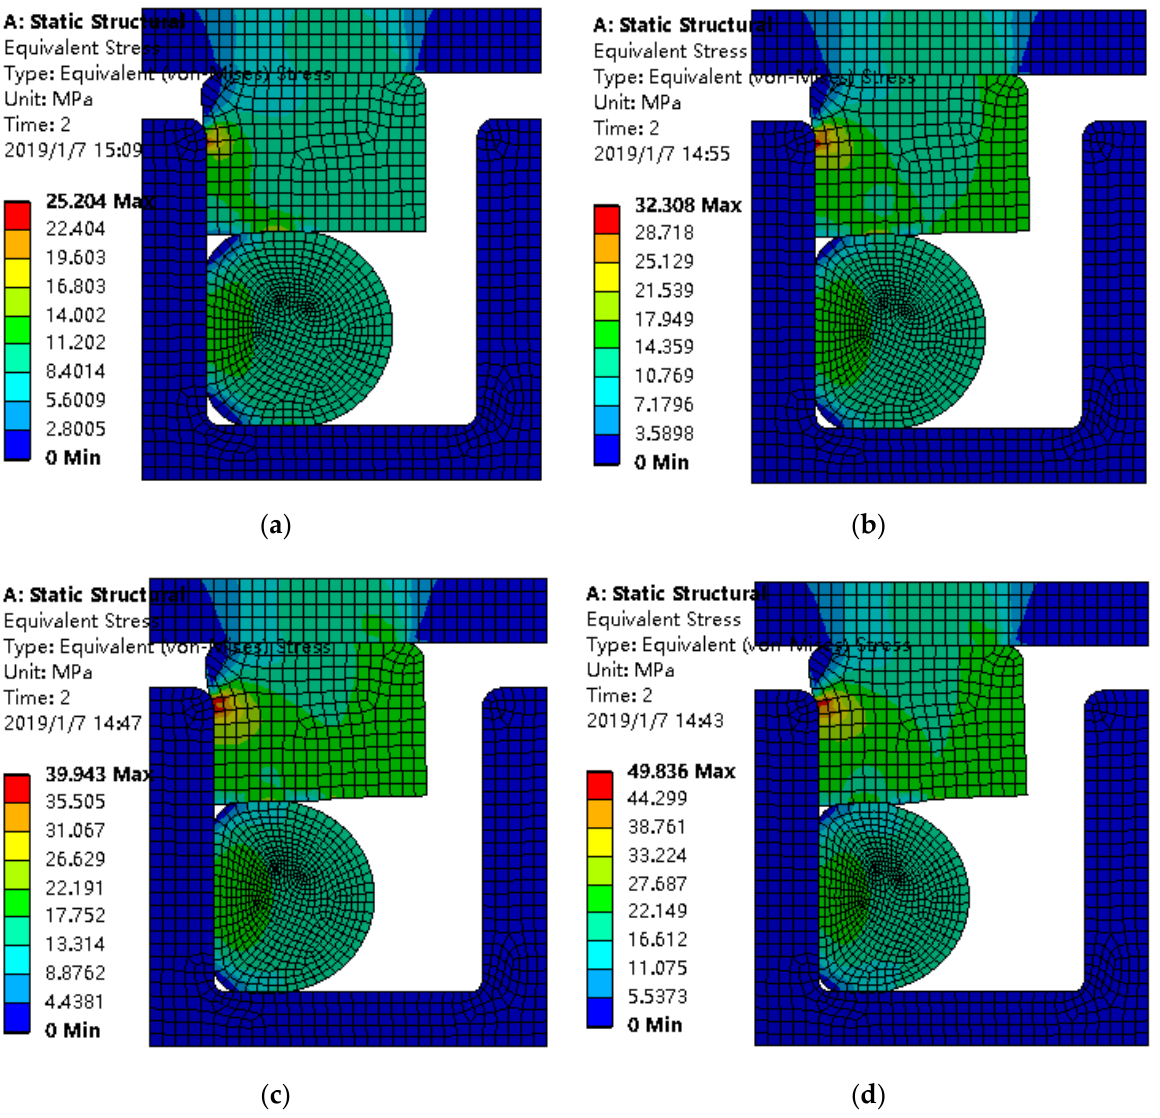
Figure 5. Stress cloud diagram of combined sealing structure. ( a ) P1 = 10 MPa; ( b ) P2 = 15 MPa; ( c ) P3 = 20 MPa; ( d ) P4 = 25 MPa.